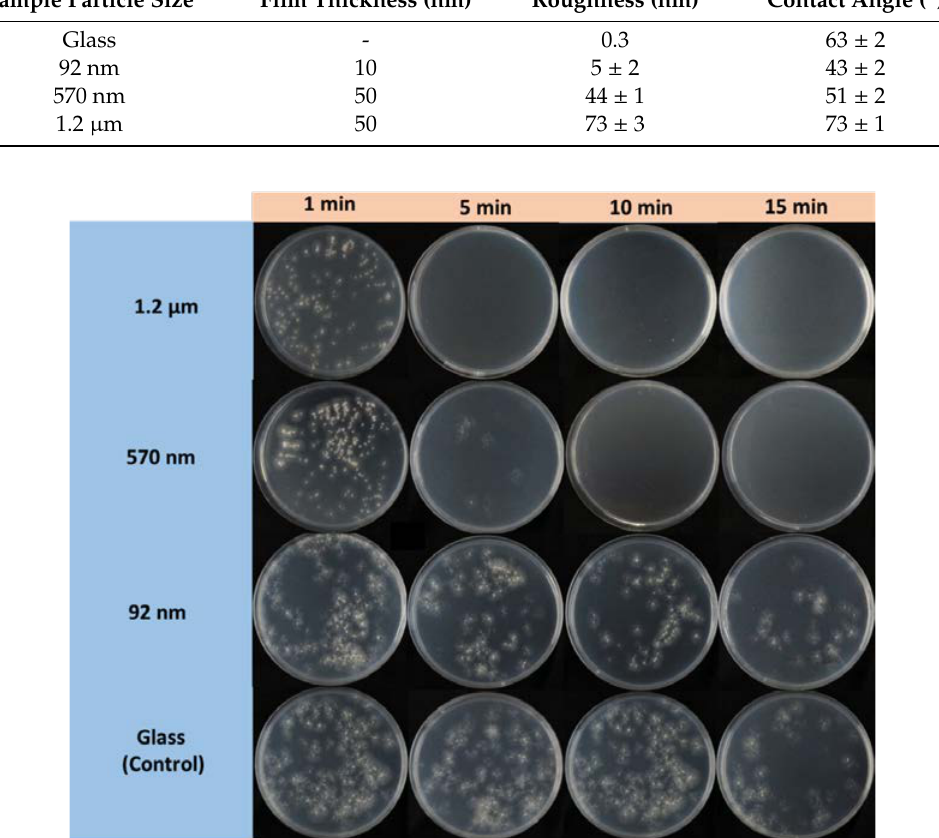
ff erent Ag particle sizes and contact